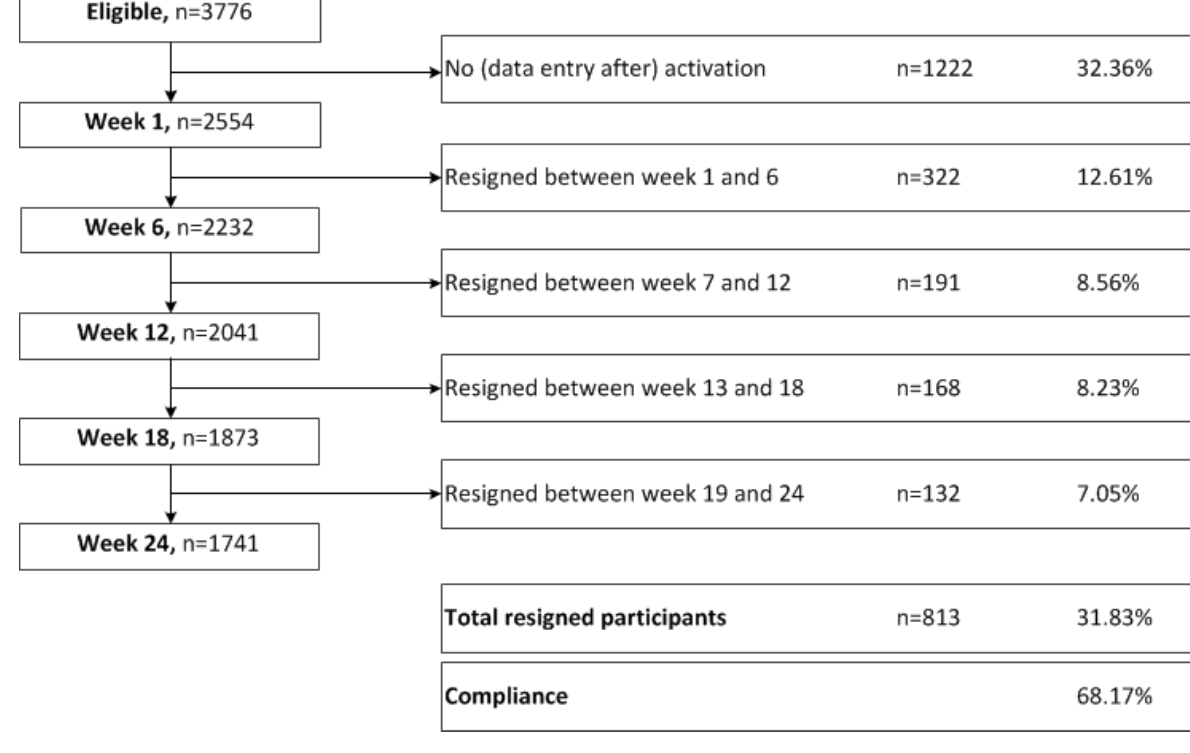
Figure 1. Flowchart of study participants that completed or resigned from the Smarter Pregnancy mobile health coaching